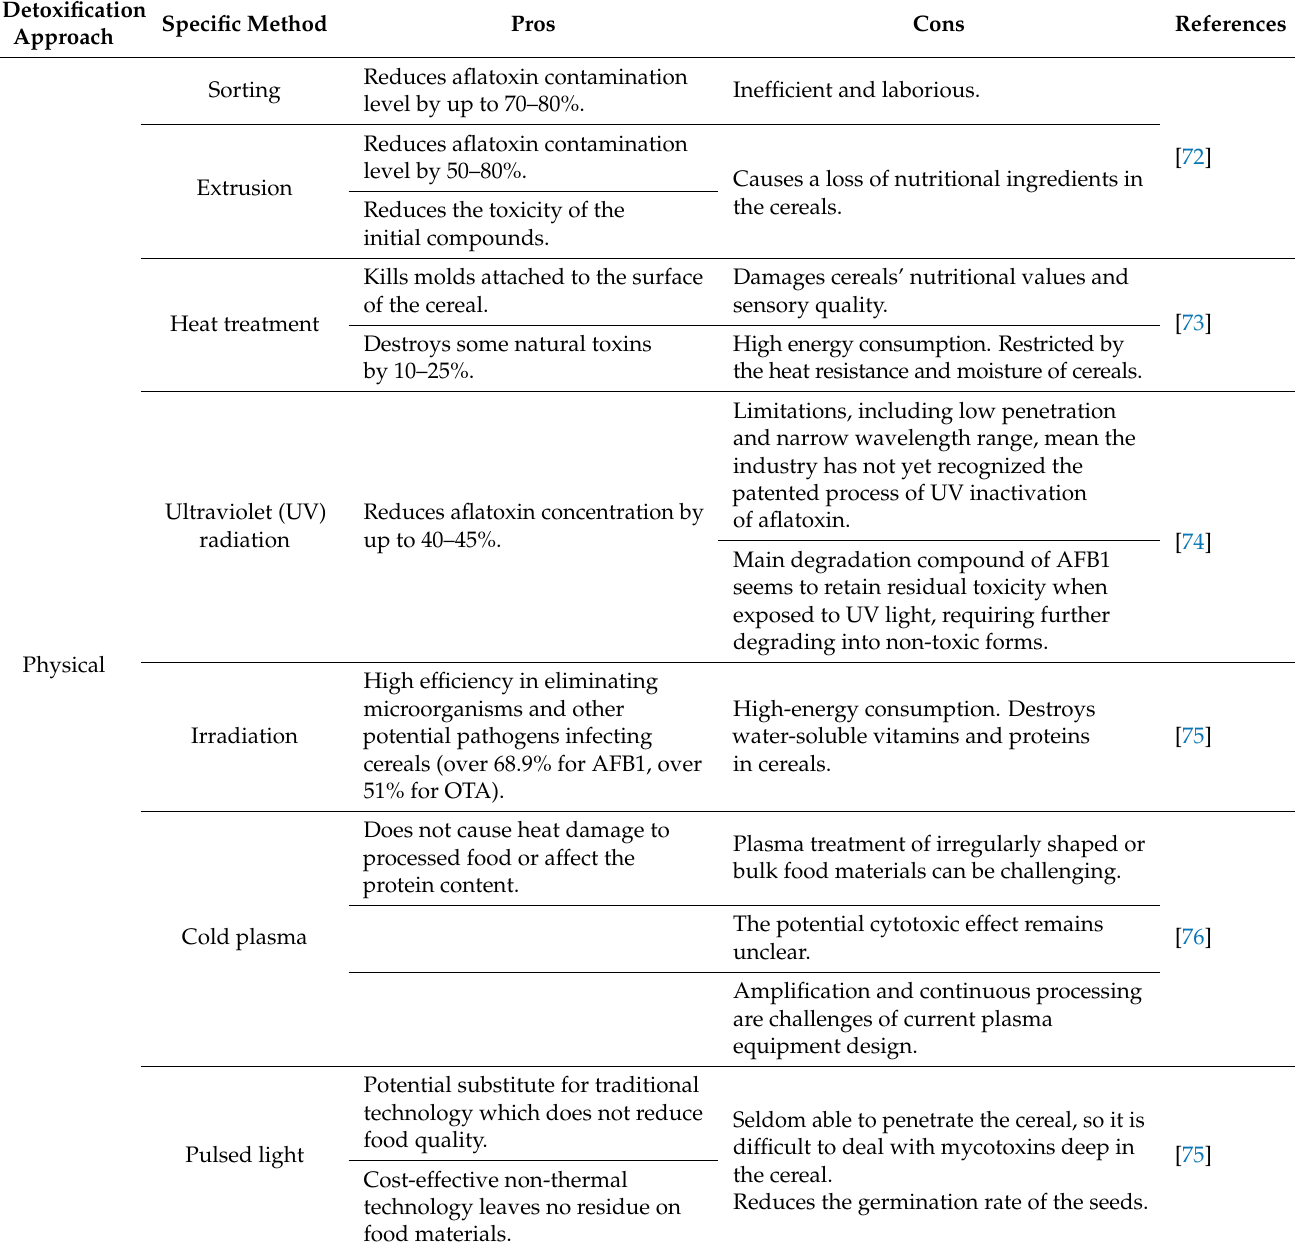
Table 2. Physical and chemical detoxification methods with